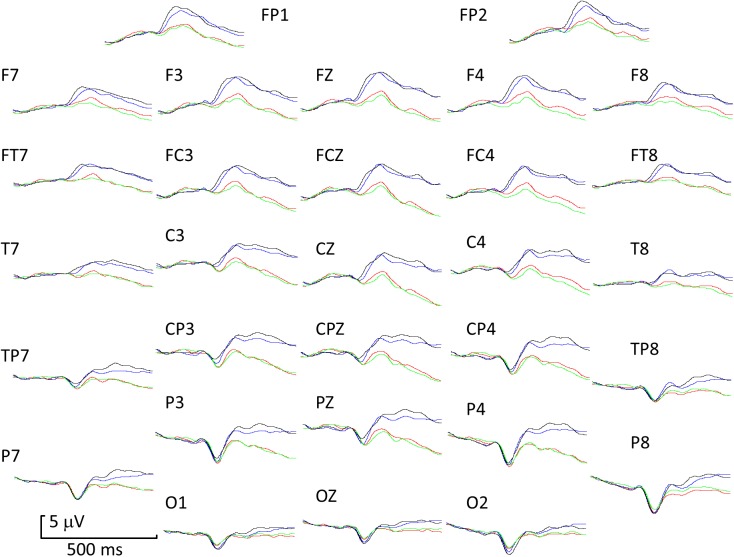
Grand-average ERP waveforms transitions between neutral and happy or neutral and frightened facial expressions.Blue trace = neutral-frightened, black trace = neutral-happy, red trace = frightened-neutral, green trace = happy-neutral. Positive upwards.